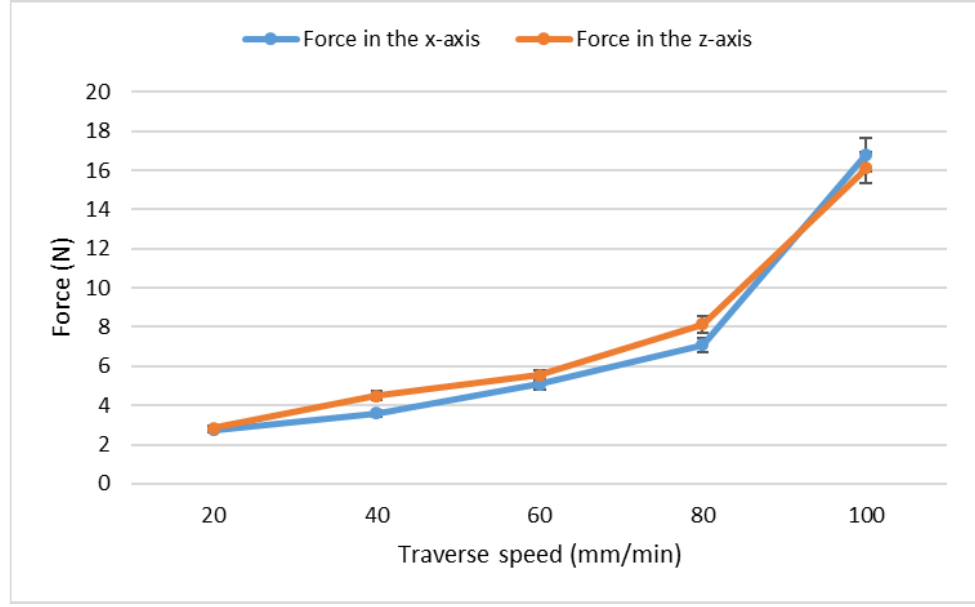
Figure 8. Measured forces in relation to the traverse speed on the steel 1.2379.